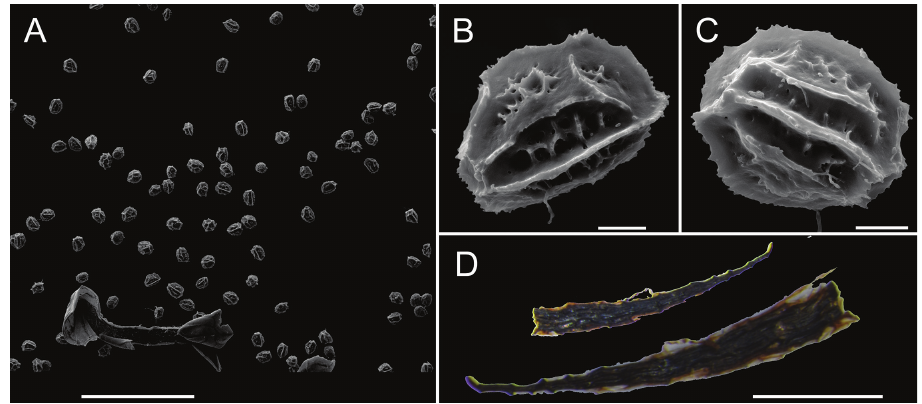
Figure 5. Asplenium jiulianshanense K.W.Xu & G.L.Xu A–C spore morphology of the new species D rhizome scale. Scale bars: 300 µm ( A ); 10 µm ( B, C ); 1 mm ( D